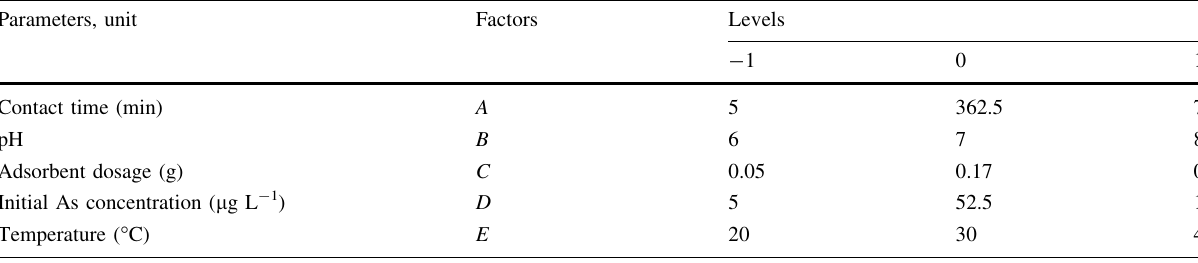
Table 1 Independent parameters and their levels used for Box–Behnken design Parameters, unit Factors